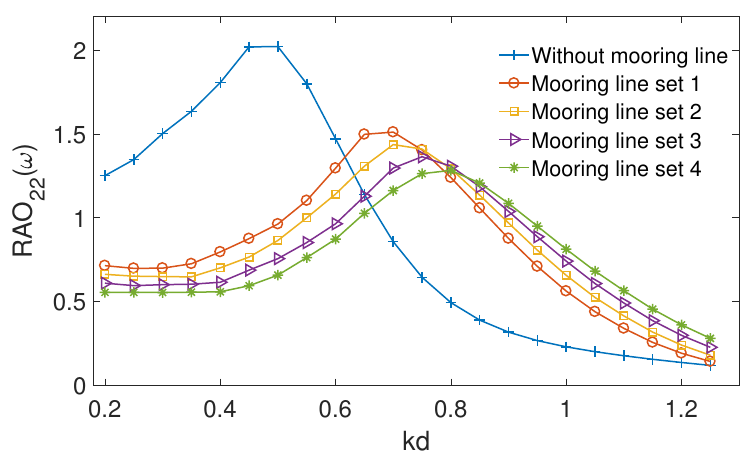
Figure 11. Comparison of the floating body heave motion RAO 22 ( ω ) between without mooring line condition, mooring line set 1, mooring line set 2, mooring line set 3 and mooring line set 4. Table 2. Parameters of four sets of mooring lines for symmetrical seabed condition with water depth h = 200 m.